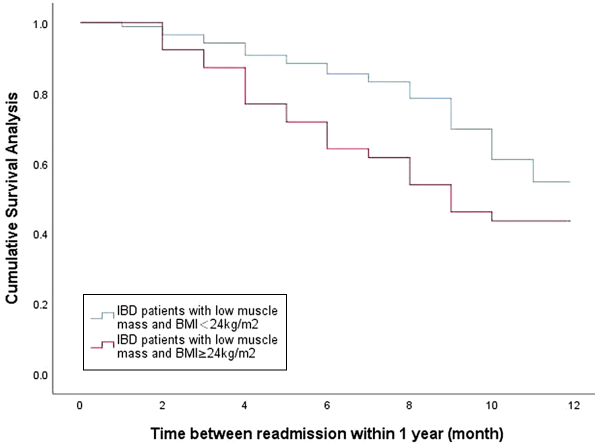
Figure 4. Cumulative survival analysis between IBD patients with low muscle mass whose BMI < 24 kg/m 2 or ≥ 24 kg/m 2 and time between readmission within 1 year. IBD, inflammatory bowel disease; BMI, body mass